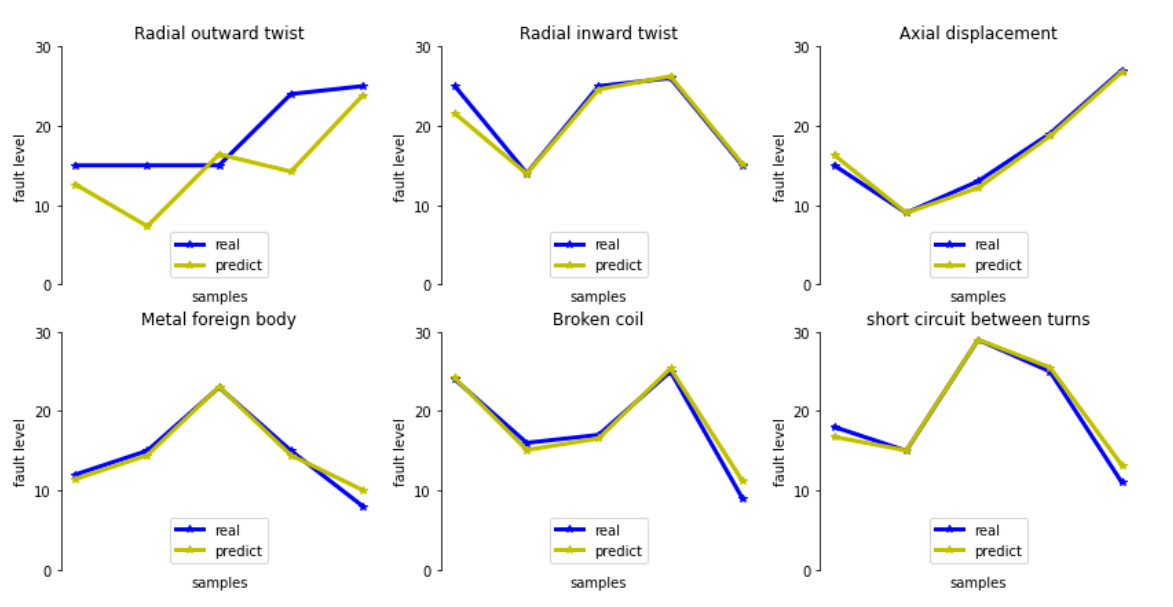
Figure 13. Model prediction results under various types of failures.